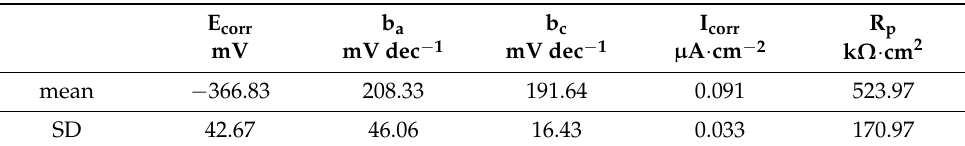
Table 5. Polarisation parameters and corrosion rates evaluated with the Tafel method (E corr —rest po- tential, b a and b c —anodic and cathodic Tafel slopes, I corr —corrosion current density, R p —polarisation resistance).